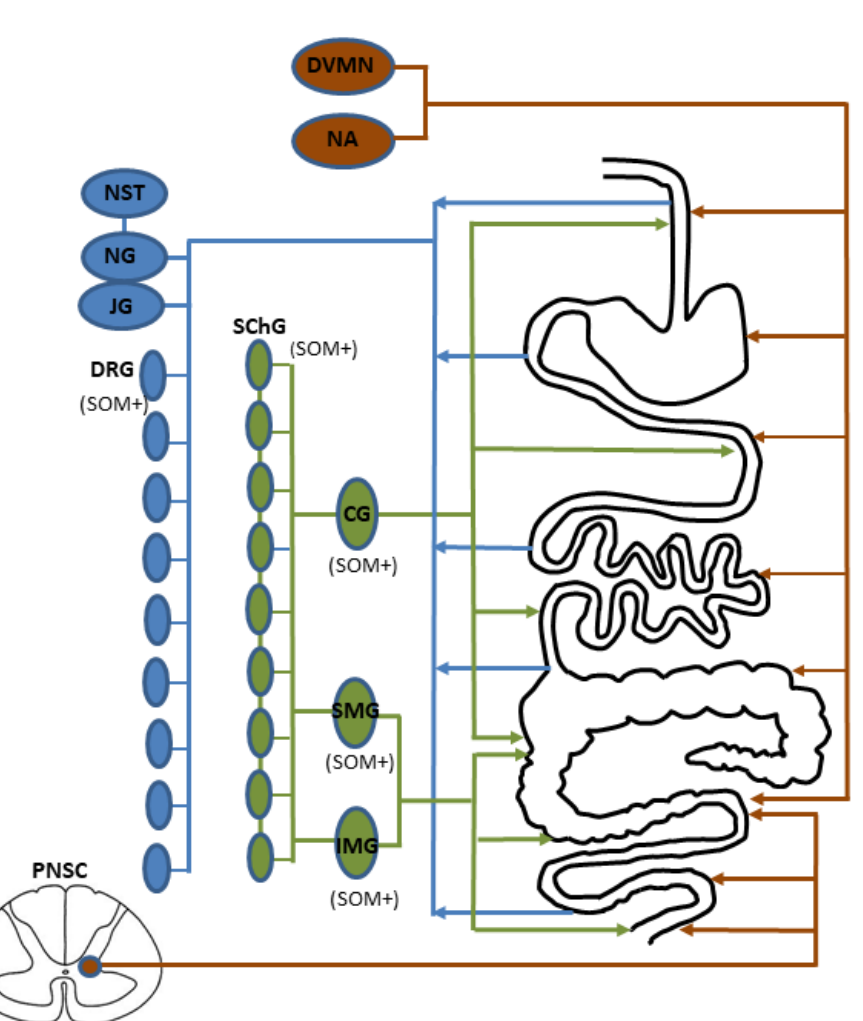
Figure 3. Organization of the extrinsic innervation of the gastrointestinal tract: blue–sensory innervation, green–sympathetic innervation, brown–parasympathetic innervation, DVMN = dorsal vagal motor nucleus, NA = nucleus ambiguous, PNSC = parasympathetic nuclei of the sacral spinal cord, NST = nucleus of the solitary tract, NG = nodose ganglion, JG = jugular ganglion, DRG = dorsal root ganglia, SChG = ganglia of the sympathetic trunk, CG = celiac ganglion, SMG = superior mesenteric ganglion, IMG = inferior mesenteric ganglion. Structures, where SOM was observed in neurons supplying the gastrointestinal tract are marked by “ (SOM+) ”.